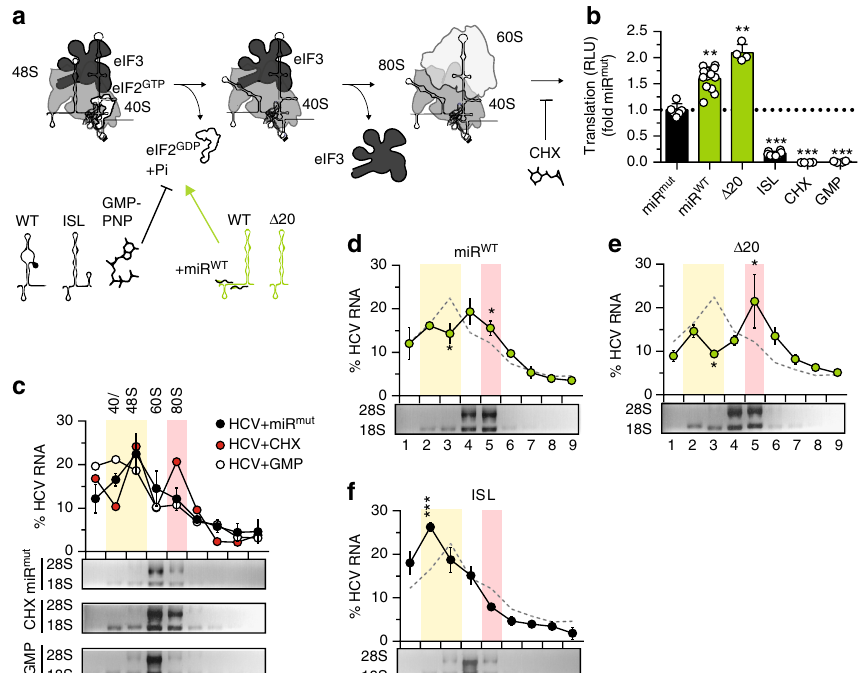
Fig. 6 Ribosome pro fi ling. a Schematic representation of translation initiation and assembly of the 80S ribosome. The 48S preinitiation complex is constituted of the 40S ribosomal subunit, eIF3 and the (eIF2) – GTP-tRNAP Met P. Hydrolysis of GTP leads to release of eIF2. The L-shape of SLII is crucial for this process. Hence, the ISL mutant, misfolded WT and GMP-PNP, inhibiting GTPase activity, stall the reaction at this stage (bar-headed line). In contrast, miR-bound WT and Δ 20 should activate eIF2-release, since SLII is effectively formed (green arrow). Subsequently, eIF3 is released and the 60S subunit is recruited to form the 80S complex. The following transition from initiation to elongation can be inhibited by CHX (bar-headed line). b Monitoring translation by luciferase assay in HeLa cell extracts, using Luc-SG in presence of miR mut or miR WT , DI mutants, GMP-PNP or CHX. c Analysis of HCV RNA distribution in ribosome pro fi les of HeLa cell extracts. Total lysates incubated with HCV in vitro transcripts were recorded; Relative abundance of HCV RNA from sucrose fractions was analyzed by qRT-PCR. Represented are percentages relative to the total amount in the gradient. The assay was performed with either no inhibitor, GMP-PNP or CHX in the reaction mix. The HCV RNA pro fi le for the control reactions is shown in the top panel. Total RNA was analyzed by denaturing agarose gel electrophoresis (lower panel) to con fi rm the presence of 18S and 28S ribosomal RNA and distinguish precisely 40/48S and 80S ribosomes. Note that in fraction 4 and 9 the CHX data points are obscured by the GMP data. d Comparison of translation initiation ef fi ciency of Luc-SG in presence of miR WT . The control with miR mut is shown as dashed line for comparison. e , f As in ( d ), comparing the WT reporter replicon and DI mutants. Mean values (±SD), n = 3, in technical duplicates. RLU relative light units. Signi fi cance was determined compared to the miR mut control. The reference graph used to calculate is given in light gray. *P<0.05, **P<0.01, ***P<0.001. 40/48S and 80S containing fractions are highlighted by yellow or orange boxes, respectively. Note that results shown in panels ( d – f ) were obtained in absence of